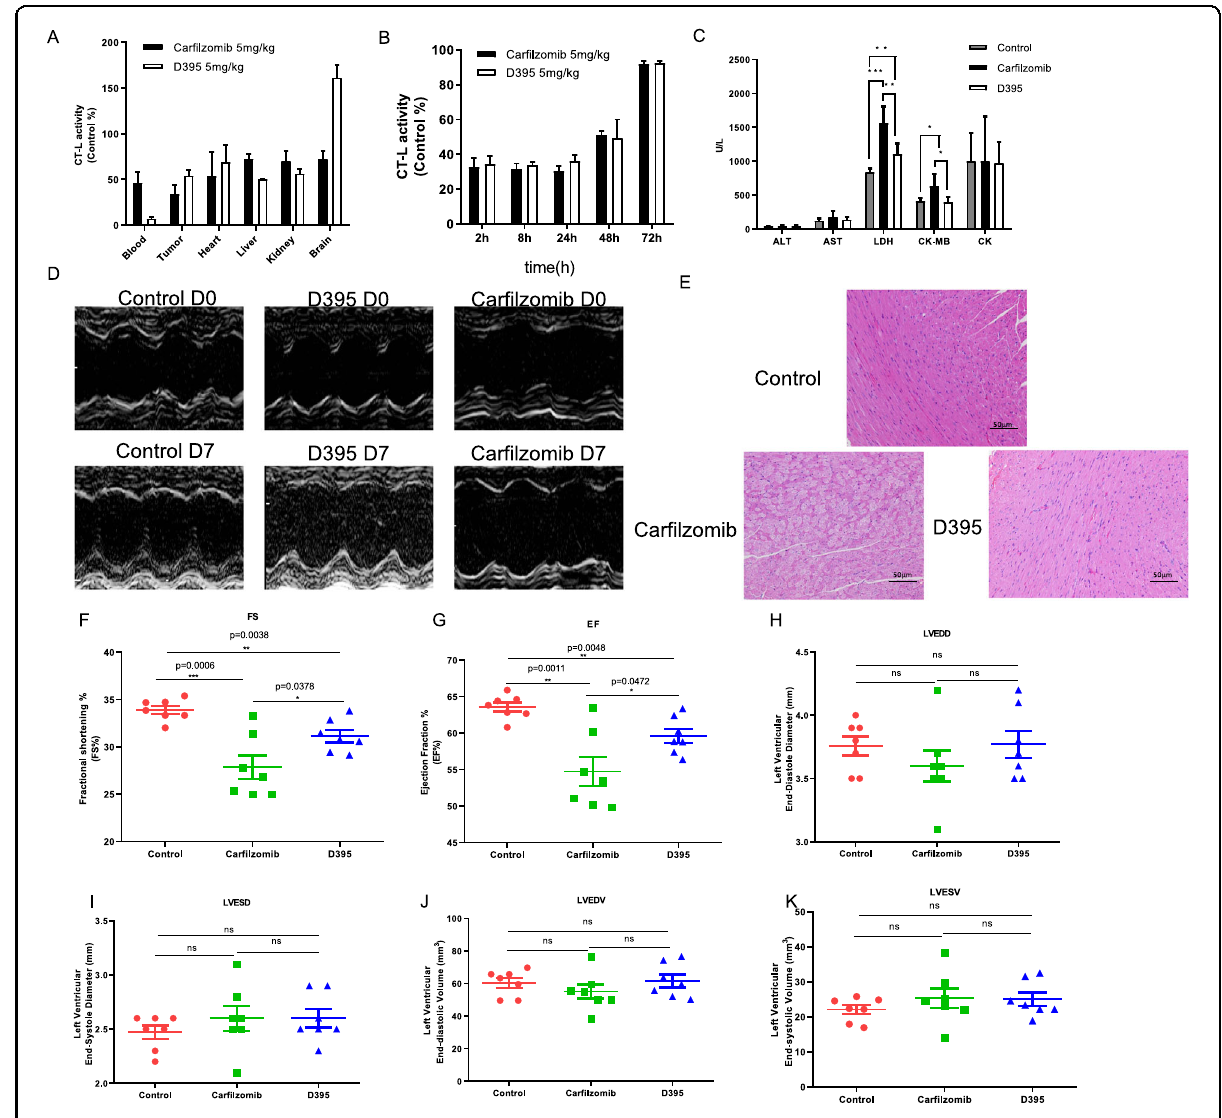
Fig. 7 D395 is signi fi cantly less cardiotoxic than car fi lzomib in vivo. Car fi lzomib (5 mg/kg) or D395 (5 mg/kg) were injected into RPMI-8226 bearing mice for 1 h, respectively. A CT-L activity was detected in organs including blood, tumor, heart, liver, kidney, and brain. B The recovery of CT-L activity was evaluated in blood at 2 h, 8 h, 24 h, 48 h, and 72 h. C The levels of CK, CK-MB, LDH, ALT, and AST in the serum of car fi lzomib and D395- treated mice were detected by an autoanalyzer. Data are expressed as the mean ± SD. D C57BL/6 mice were randomized to different treatment groups and administered vehicle (1% DMSO and 5% HP β CD), car fi lzomib (8 mg/kg) or D395 (8 mg/kg) by intraperitoneal injection every 2 days for 1 week. Representative echocardiographic M-mode images of mice at baseline (day 0) and endpoint (day 7) are shown. E H&E staining showed morphological changes in heart histopathology in the different experimental groups (scale bar = 50 μ m). F Echocardiographic assessment of cardiac function in mice was used to record FS, EF, LVEDD, LVESD, LVEDV, and LVESV (LVEDD: Left ventricular end-diastole diameter; LVESD: Left ventricular end-systole diameter; LVEDV: Left ventricular end-diastolic volume; LVESV: Left ventricular end-systolic volume; FS: Fractional shortening; EF: Ejection fraction; ALT: Alanine aminotransferase; AST: Aspartate transaminase; LDH: Lactic dehydrogenase; CK-MB: Creatine kinase-MB; CK: Creatine